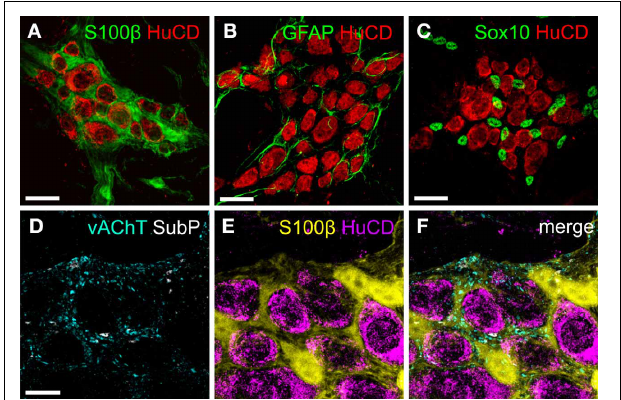
FIGURE 1 | The relation between enteric neurons and glia visualized by immunohistochemistry. (A,C) Maximum projection of colonic myenteric ganglia of mice stained for the pan-neuronal marker HuCD (red) and enteric glial cell markers (green) S100 β (A) , GFAP (B) , and Sox10 (C) . (D,E) Maximum projection composed of a stack of two confocal images of a mouse colonic myenteric ganglion labeled with antibodies for S100 β (glia, yellow) and HuCD (neurons, magenta) and for vAChT (cyan) and substance P (grays) revealing the close apposition of neuronal fibers and varicosities with enteric glial cells (F) . Scale bars: 25 μ m (A–C) , 10 μ m (D)